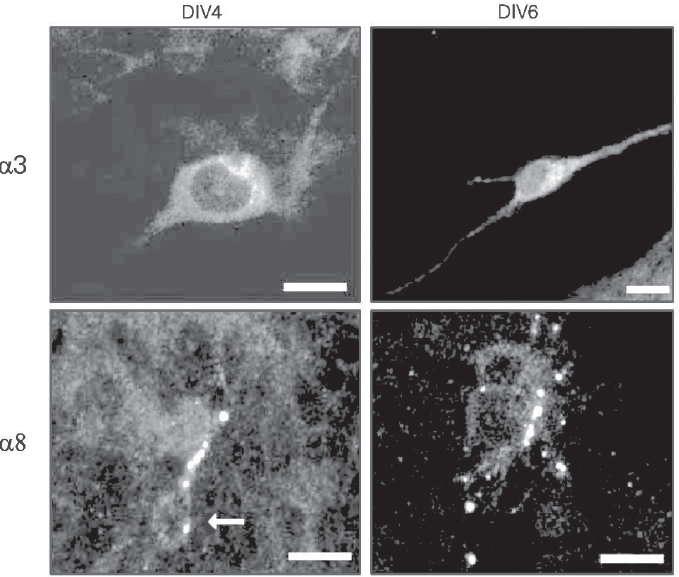
Figure 1. Confocal laser scanning images of retinal cells from 4th and 6th day in vitro (DIV4 and DIV6) cultures labeled with antibodies against α 3 and α 8 subunits, and visualized with tetramethylrhodamine isothiocyanate. α 3-like immunoreactiv- ity can be seen in the perykarion and proximal processes, and α 8 in a varicose process. The arrow points to the somata of cells labeled with the α 8 monoclonal antibody. Scale bar: 10